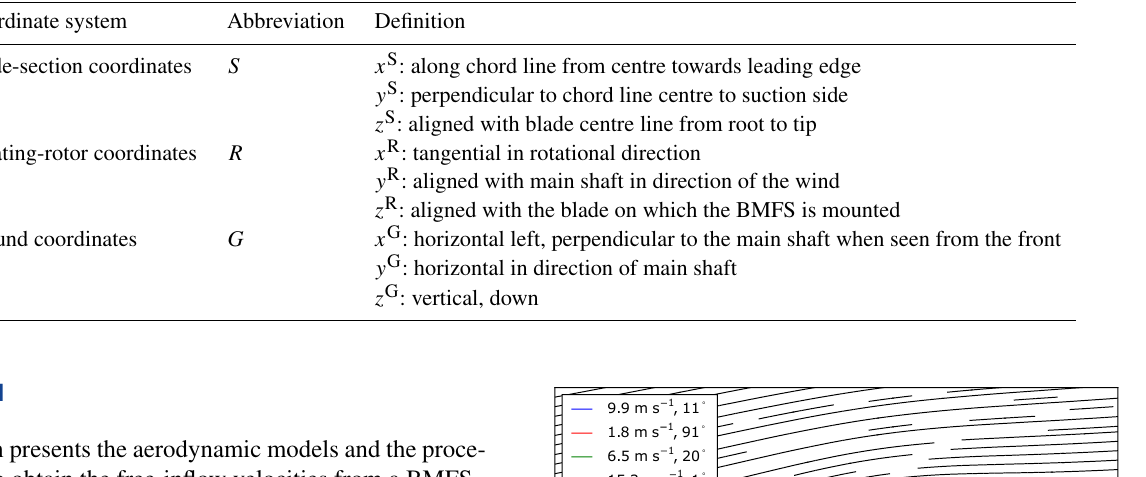
Table 1. Coordinate systems used in this paper. Coordinate system Abbreviation